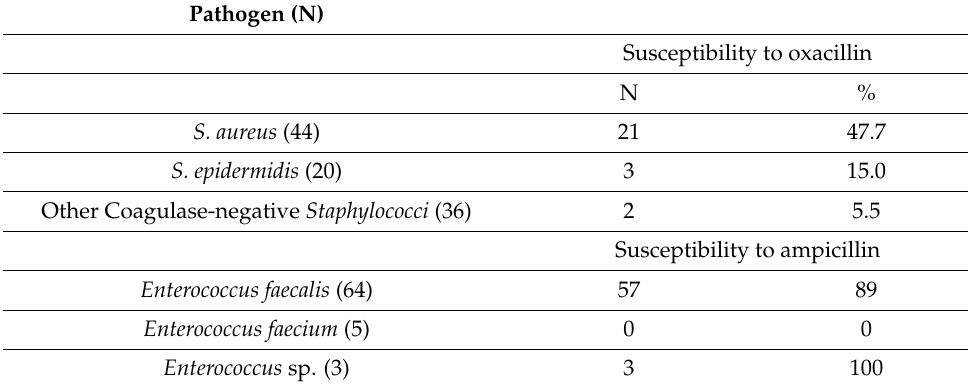
Table 2. Susceptibility pattern of the Gram-positive pathogens.